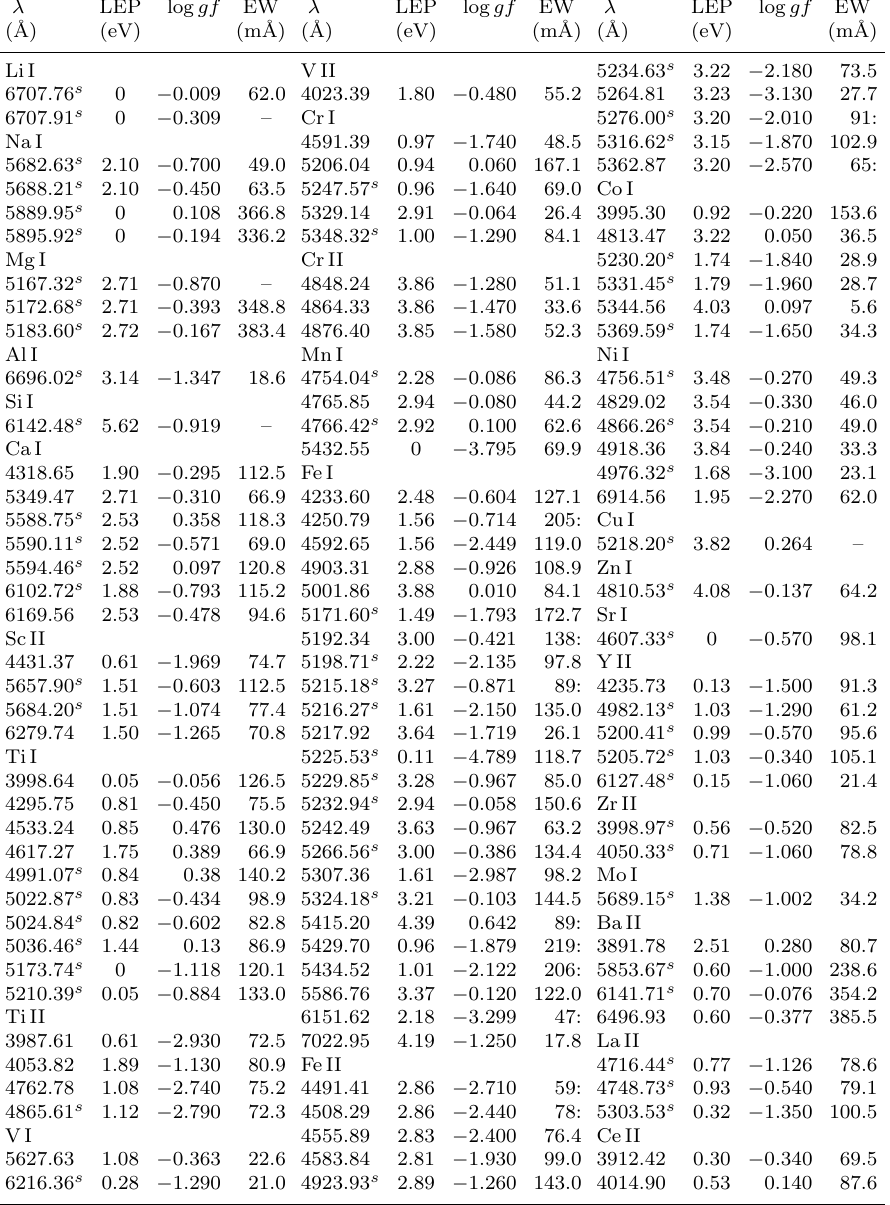
Table 2. Wavelengths, excitation potentials, oscillator strengths and equivalent widths of the lines used for abundance calculations in the spectrum of HD 209621. The lines calculated using the method of spectral synthesis are marked by s